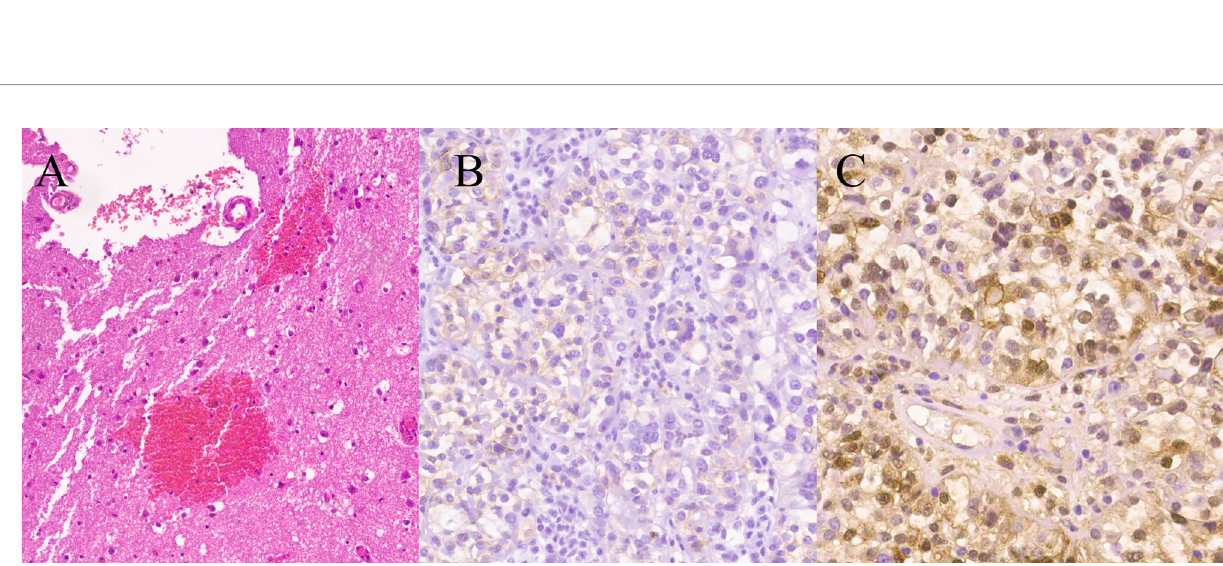
Frontiers in Oncology |